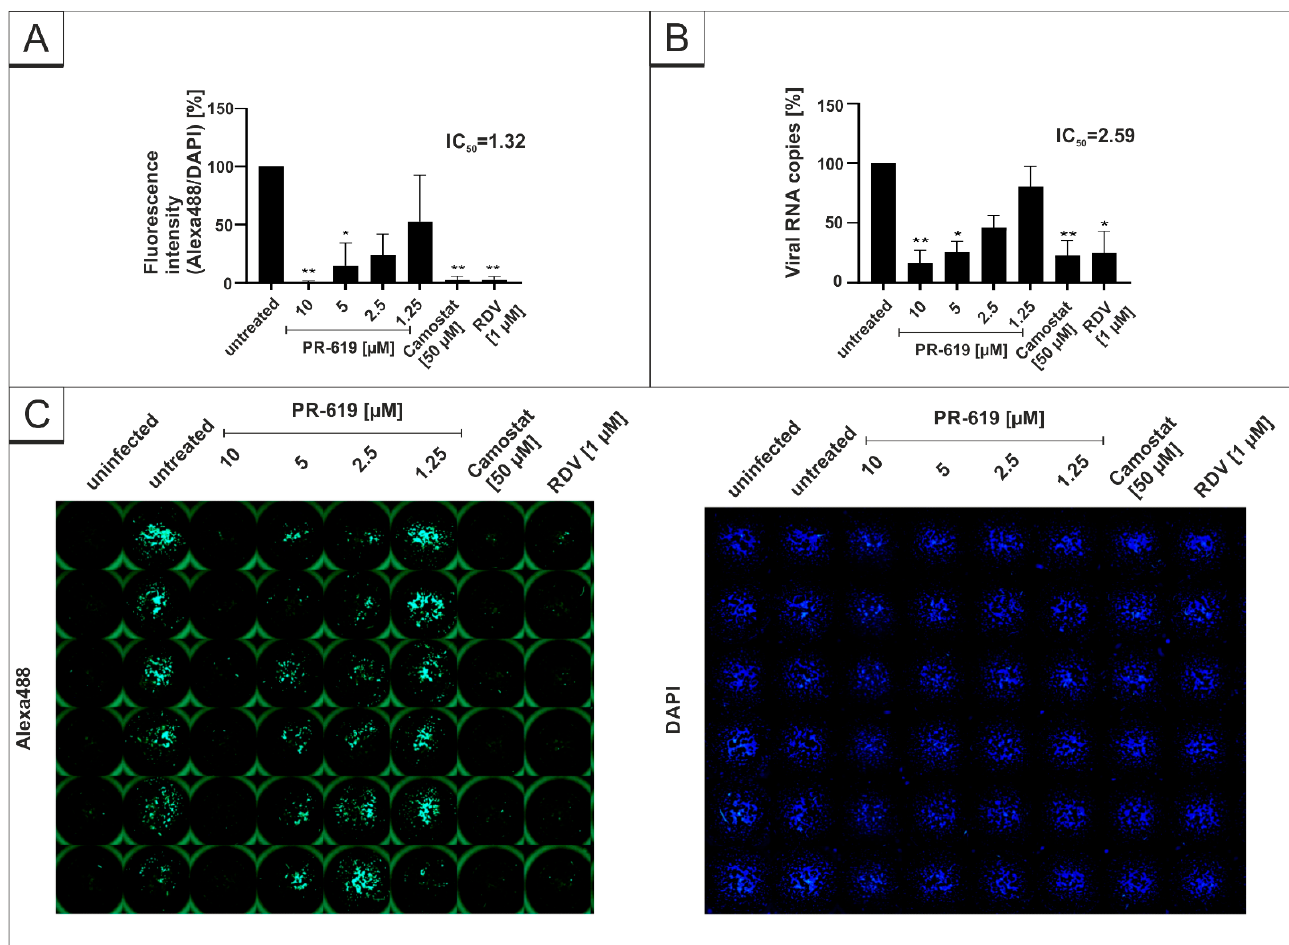
Figure 3. PR-619 inhibits SARS-CoV-2 replication in Calu-3 cells. Quantitative analysis of fluorescence microscopy ( A ), qRT-PCR of cell culture supernatants ( B ) and representative images of fluorescence staining ( C ) 30 h post infection. Cells were analyzed via microscopy using anti-SARS-CoV-2 NP-antibody. Bars show mean values of three independent experiments ± standard deviation. Statistical analysis was performed using a multiple comparison Kruskal–Wallis test (Anova) followed by Dunn’s post hoc test (* p < 0.05; ** p < 0.01).